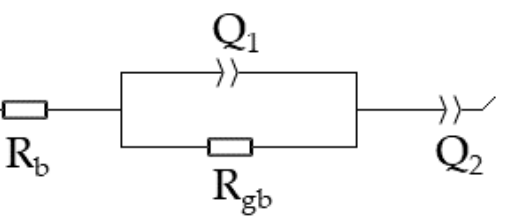
Figure 1. Equivalent circuit used for fitting the Nyquist plot. R b represents the starting point of the semicircle at high frequencies. R gb and the constant phase element Q 1 represent the size of the semicircle. Q 2 represents the low-frequency area caused by electric contact and is of no further interest for this work.